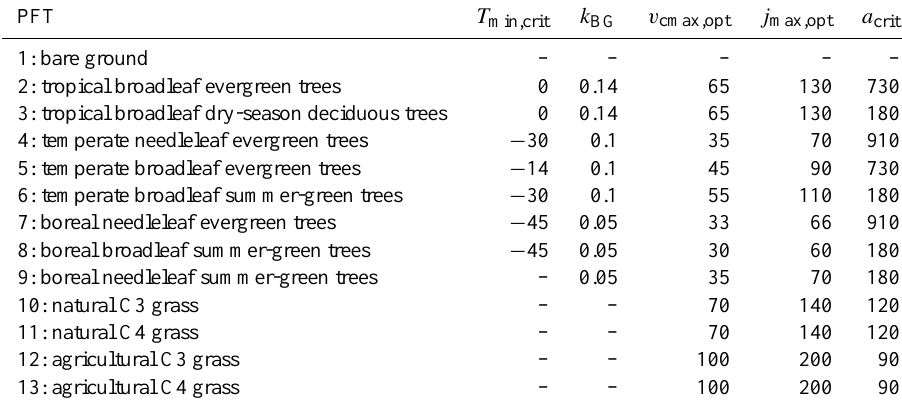
Table 1. PFT-specific parameters in ORC-HL-NVD.